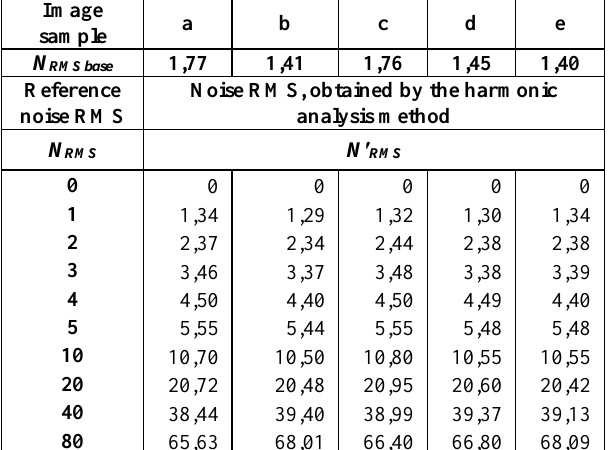
Table 2. The results of random noise assessing based on harmonic analysis for satellite images samples The results in Table 2 indicate that harmonic analysis method showed a stable result when assessing images with different types of terrain surface. It confirms the method’s invariance to this factor and the possibility of it’s application for assessing the quality of aerial and satellite images.